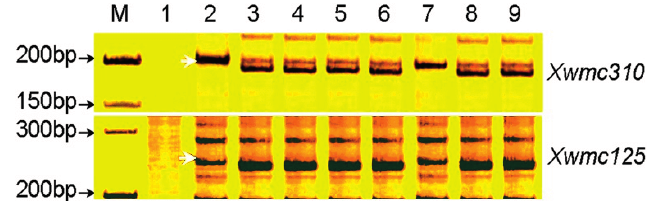
Figure 1. Silver-stained polyacrylamide gels showing simple sequence repeat (SSR) markers Xwmc310 and Xwmc125 . Lanes 1 : Th . intermedium Z1141; 2 : TAI7045; 3 : Jin